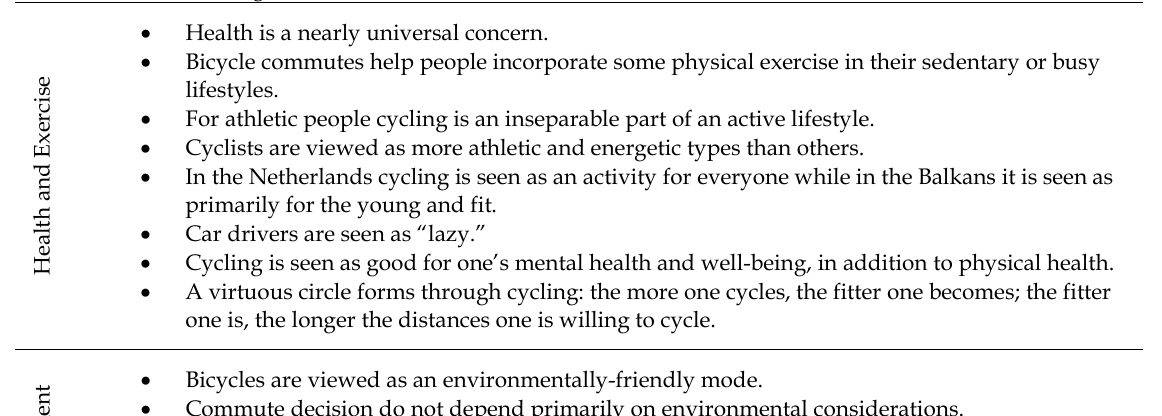
Table 3. Summary of findings Theme Main